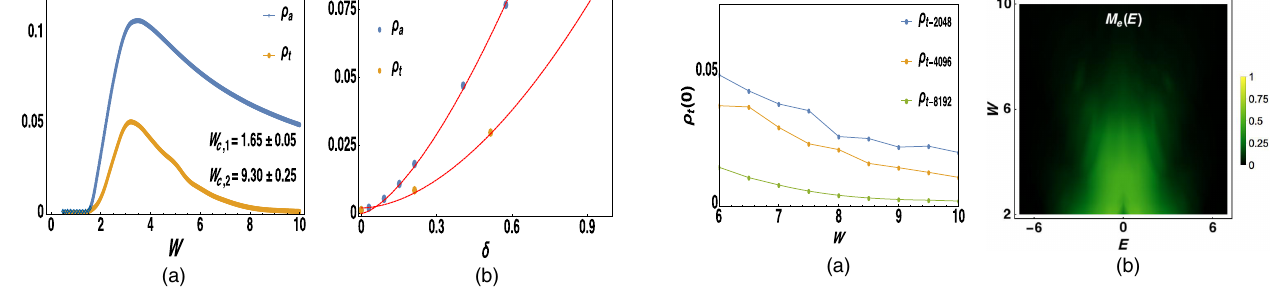
FIG. 19. (a) Scaling of typical density of states at zero energy 0 Þ ] and typical [ ϱ 0 Þ ] FIG. 18. (a) Scaling of average [ ϱ a ð t ð ϱ 0 Þ for disorder ( W ) within the range 6 . 0 ≤ W ≤ 10 . 0 with the t ð density of states at zero energy as a function of disorder strength. 0 Þ for number of Chebyshev moments N . We here compute ϱ m t ð The Weyl semimetal-metal and metal-Anderson insulator quan- 2048 , 4096, and 8192. From the scaling of ϱ 0 Þ versus N 1 . 65 (cid:2) m ¼ t ð tum phase transitions, respectively, take place at W c; 1 ¼ N , we find that metal-insulator Anderson transition takes palce 9 . 30 (cid:2) 0 . 25 . (b) Scaling of these two quantities 0 . 05 and W m c; 2 ¼ 9 . 30 in the N → ∞ limit. (b) Mobility edge M E Þ at W c; 2 ¼ m e ð =W , yielding corresponding as a function of δ ¼ ð W − W c; 1 Þ c; 1 [defined in Eq. (61)] as a function of energy ( E ) and disorder ( W ). 1 . 50 (cid:2) order-parameter exponents [defined in Eq. (58)] β a ¼ Respectively, the green and the dark regions accommodate 0 . 05 and β 1 . 80 (cid:2) 0 . 20 . t ¼ E Þ is extended or metallic and localized states. Scale of M e ð shown in the legend. Here the system size is L ¼ 80